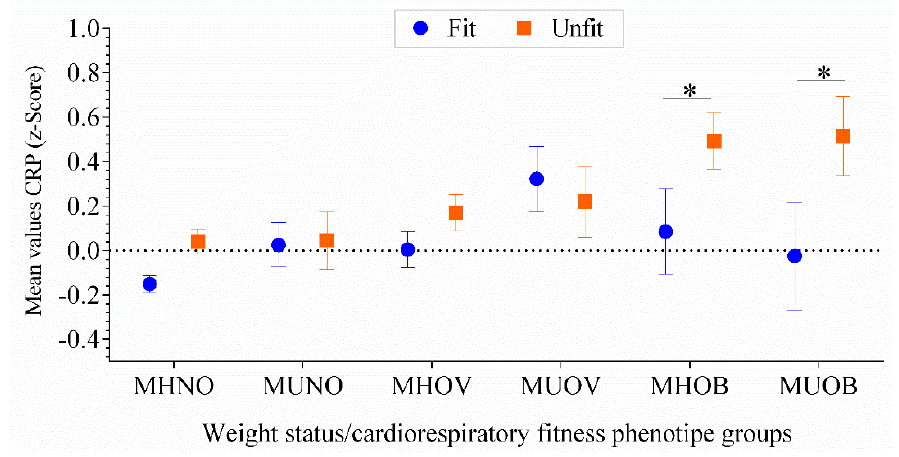
Figure 3. High-sensitive CRP levels across different metabolic groups. Two-way ANCOVA models adjusted for age, sex, pubertal stage and country (F = 4.423, p = 0.03). The dashed line represents a value of zero for the scores, and a higher score represents a greater high-sensitive CRP Z-score. The asterisks show the difference in the high-sensitive CRP z-scores for the unfit adolescents compared with the fit adolescents ( p < 0.04 for all). MHNO, n = 720 (fit) and 310 (unfit); MUNO, n = 99 (fit) and 59 (unfit); MHOV, n = 151 (fit) and 148 (unfit); MUOV, n = 46 (fit) and 38 (unfit); MHOB n = 27 (fit) and 60 (unfit). MUOB n = 17 (fit) and 31 (unfit). Metabolically healthy non-overweight (MHNO); metabolically unhealthy non-overweight (MUNO); metabolically healthy overweight (MHOV); metabolically unhealthy overweight (MUOV); metabolically healthy obese (MHOB); and metabolically unhealthy obese (MUOB).